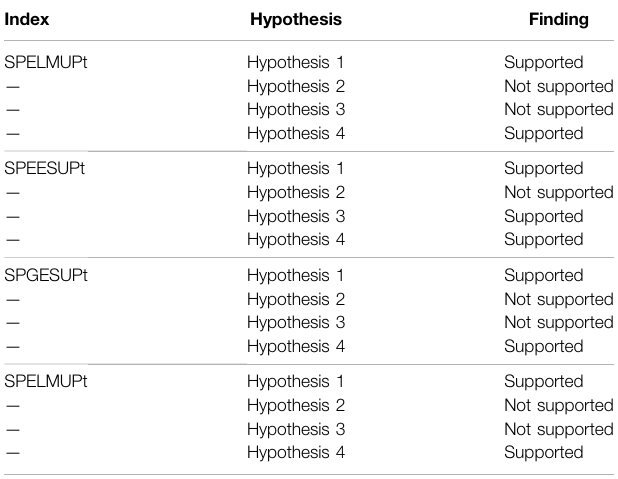
TABLE 11 | Results of the assessment of COVID-19 effect on ESG stock market